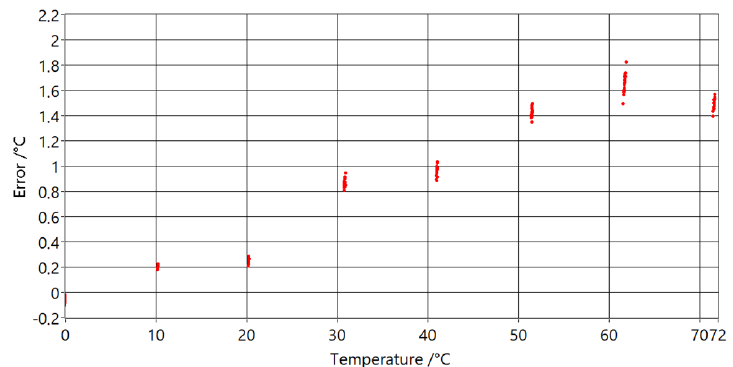
Figure 17. Temperature error versus reference temperature readings with speed of sound calculated by the Frequency Modulated Continuous Wave Acoustic Signal (CWFM) technique with separated microphone and loudspeaker.